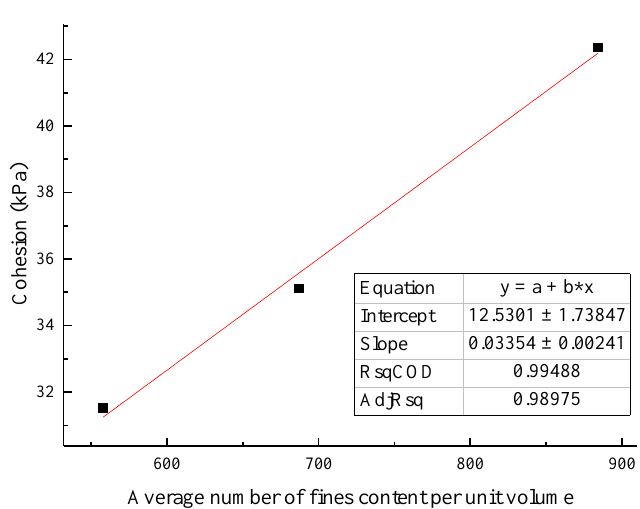
Figure 24. Fitting curve of the fine particle content and cohesion per unit volume.